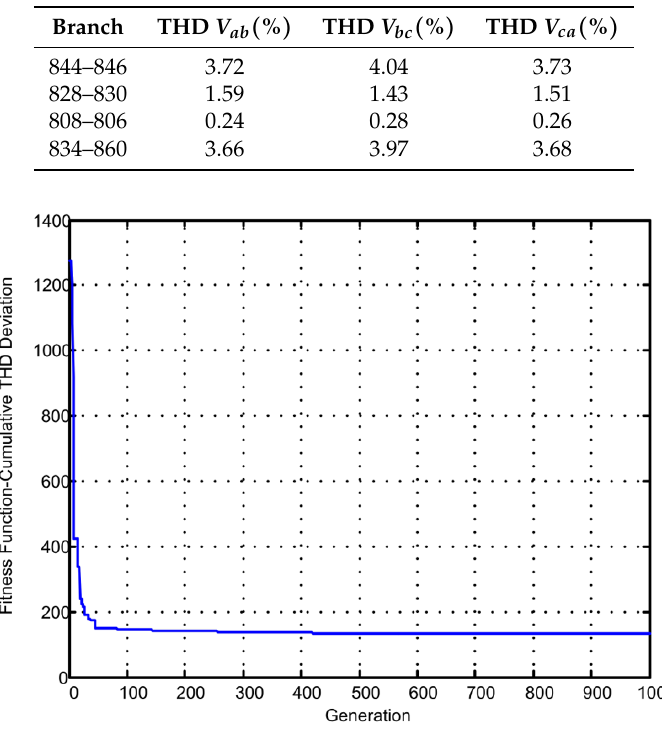
Figure 7. Cumulative voltage THD over the GA iterations (High EV